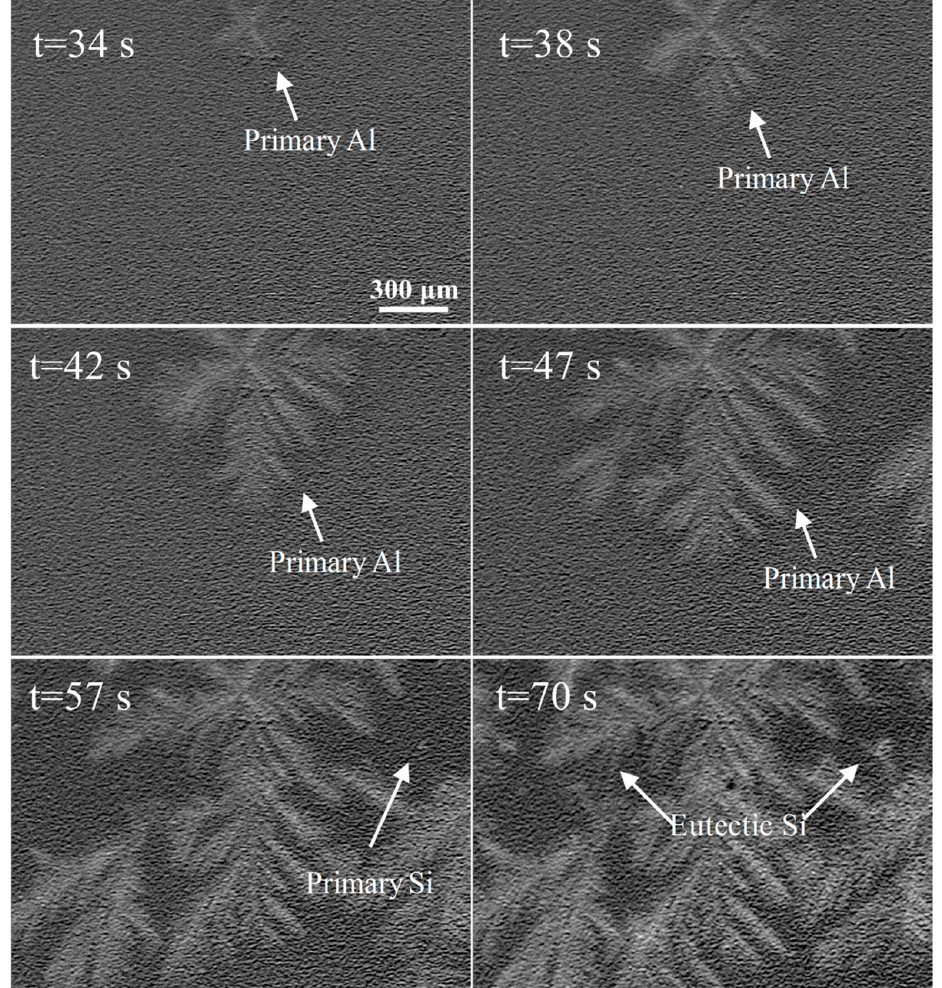
Figure 11. The series of radiographs at different times showing the solidification sequence of the high-purity Al-40Zn-5Si alloy.